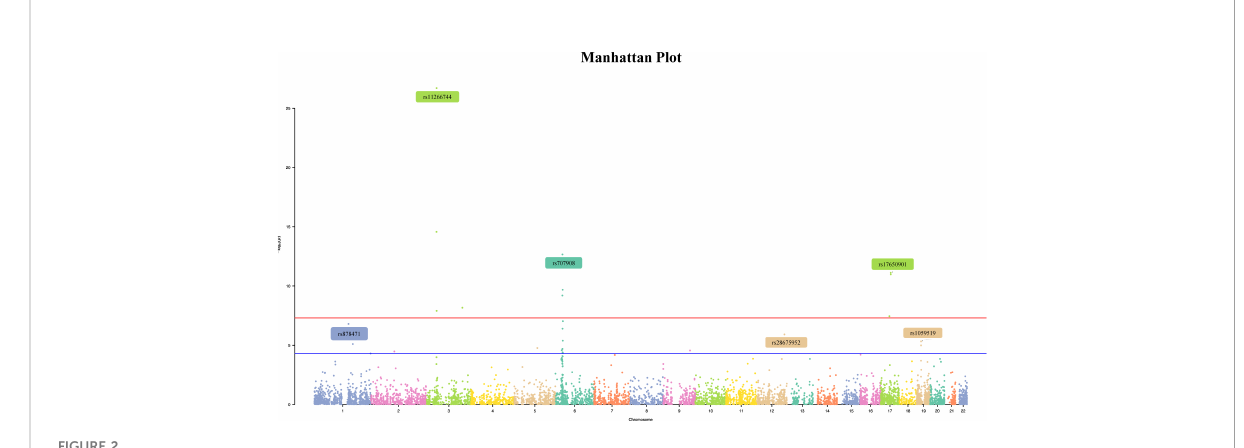
FIGURE 2 The Manhattan curve of genome-wide identi fi cation of m6A-SNPs associated with oral ulcers. The Manhattan plot showed that among the 7490 m6A-SNPs associated with oral ulcers, 11 SNPs reached the genome-wide signi fi cance threshold (p<5E- 8), and 30 SNPs reached the genome-wide prompt threshold (p<5E-5).